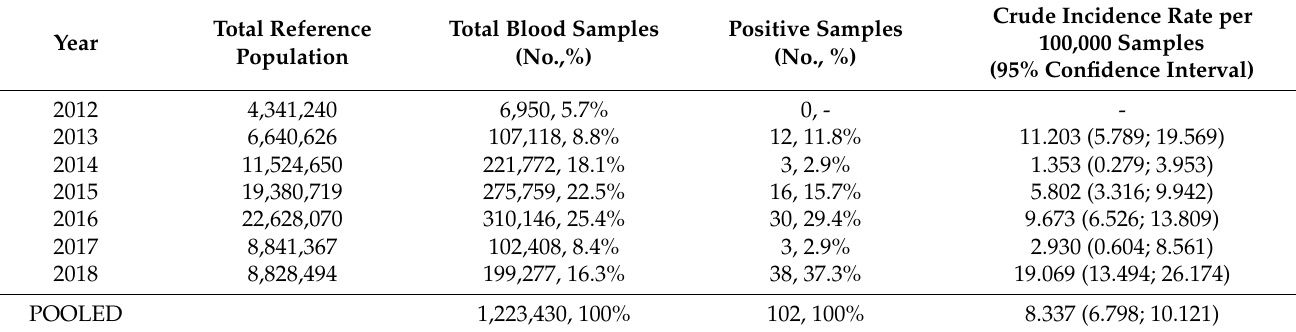
Table 5. Incidence of West Nile virus (WNV) infections diagnosed in blood donors (2012–2018). Total reference population was calculated on the geographical areas where samples from donors were collected and analyzed for WNV RNA. Incidence rates were calculated on the total number of blood